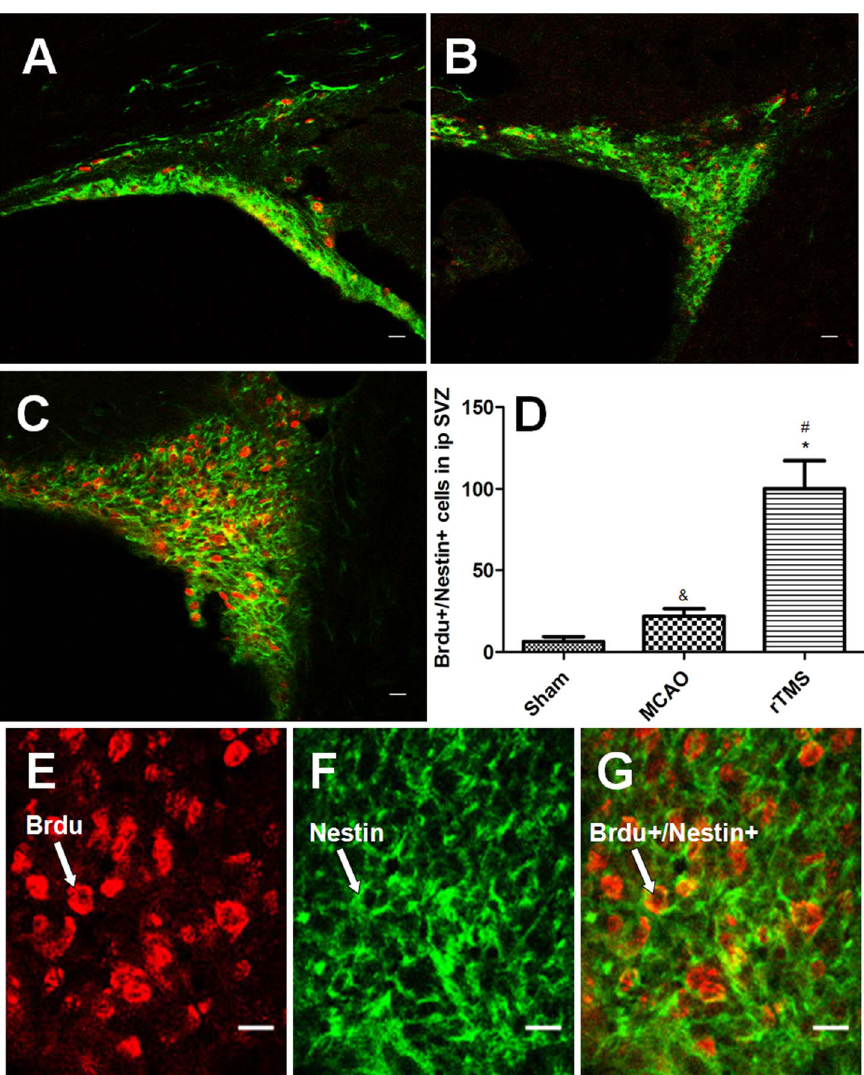
Figure 4. Confocal image of Brdu (red) and Nestin (green) co-immunofluorescence staining in the ipsilateral SVZ 7 days after surgery. Panels A–C show staining of Brdu + /Nestin + positive cells in the ipsilateral SVZ from Sham (A), MCAO (B), and rTMS (C) groups (Bar=20 m m). (D) Quantification analysis of the number of Brdu + /Nestin + positive cells in the ipsilateral SVZ 7 days after surgery. Brdu positive cells were labeled red (E), Nestin positive cells were labeled green (F) and Brdu + /Nestin + positive cells were double-labeled (G), Bar=20 m m. # P , 0.001 for rTMS group versus Sham group; * P =0.001 for rTMS group versus MCAO group. & P =0.044 for MCAO group versus Sham group. SVZ, subventricular zone. group, the sham-operated group, and the rTMS group (n= 5 for each group). All data were derived by the calculations of 2 2 DD CT and were normalized to the expression of U6. The results revealed that (1) miR-25 levels in the model group were up-regulated 2.3- fold relative to the levels in the sham-operated group (2.55 versus 1.09, p , 0.001), and (2) the miR-25 expression level in the rTMS group was also significantly up-regulated 4.3-fold relative to the sham-operated group (4.65 versus 1.09, p , 0.001) and 1.8-fold relative to the model group (4.65 versus 2.55, p , 0.001). These data suggested that tMCAO slightly induced the up-regulation of miR-25 and that 10 Hz rTMS prominently strengthened this effect (Figure 5).